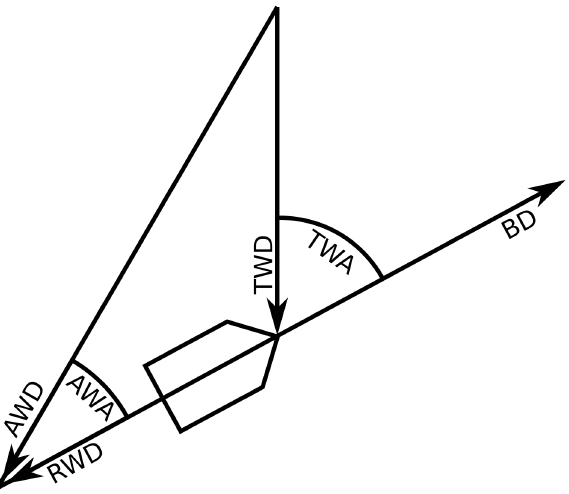
Figure 2. Vector diagram showing the relations between boat direction (BD), true wind direction (TWD), true wind angle (TWA), apparent wind angle (AWA) apparent wind direction (AWD), apparent wind angle (AWA) and relative wind direction (RWD). See also page 16 in